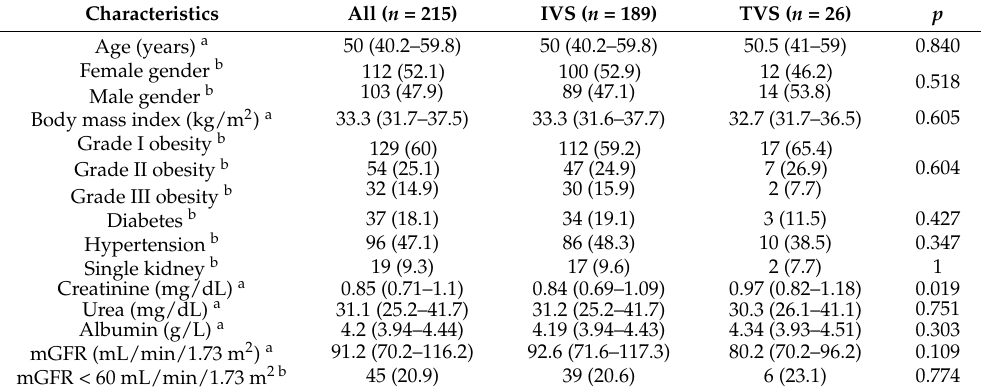
Table 1. Characteristics of all the patients, in the internal validation sample (IVS) and in the temporary validation sample (TVS).